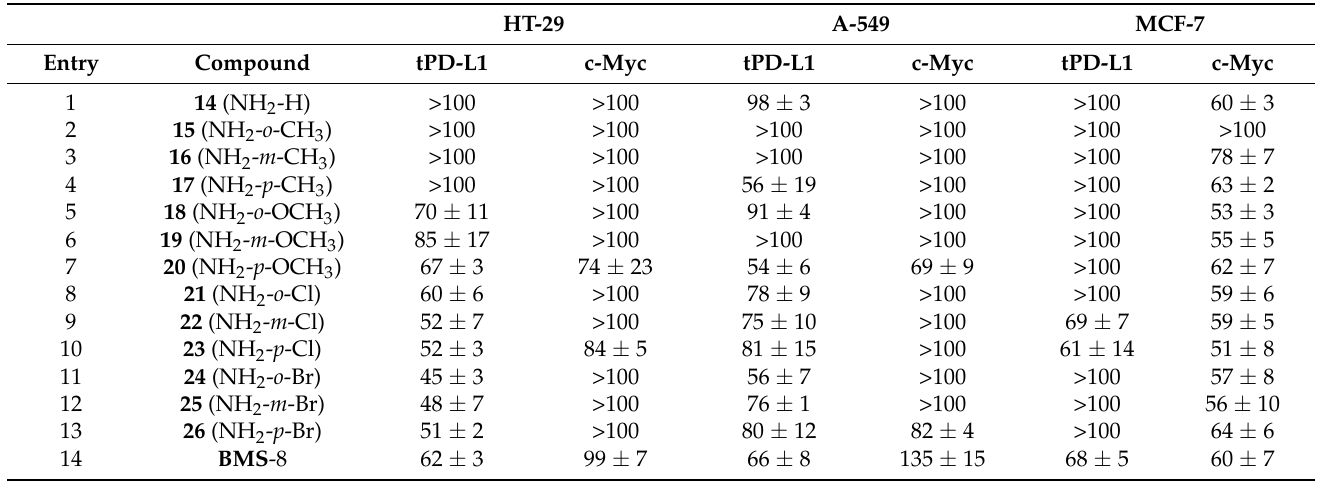
Table 3. Total PD-L1 and c-Myc protein relative detection on HT-29, A-549, and MCF-7 cell lines for compounds 14 – 26 and BMS-8 1 .